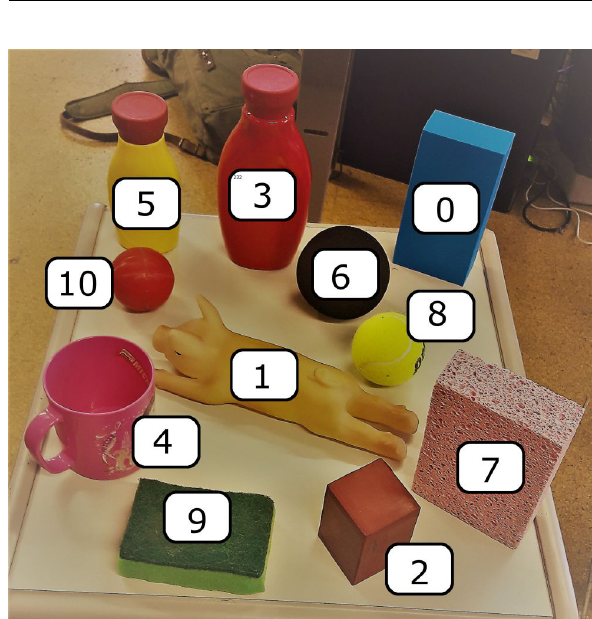
Table 3: Handshake classification results for the Field Based Classifier on each test run, and the overall miss-classification error mean.